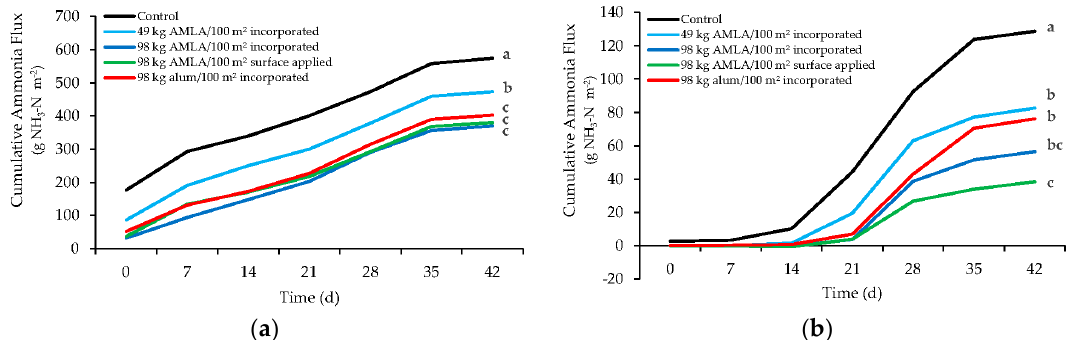
Figure 4. Cumulative ammonia flux (mg NH 3 -N m − 2 ) for ( a ) flock 2 and ( b ) flock 3 as a function of time. Treatments on day 42 not sharing a common letter are significantly different ( p < 0.05).